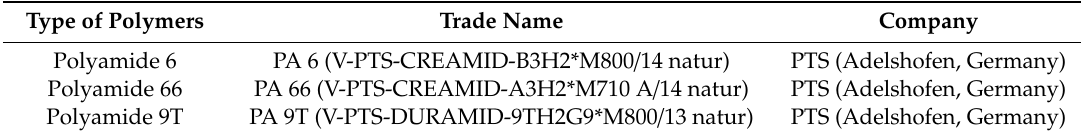
Table 1. Tested polymers.